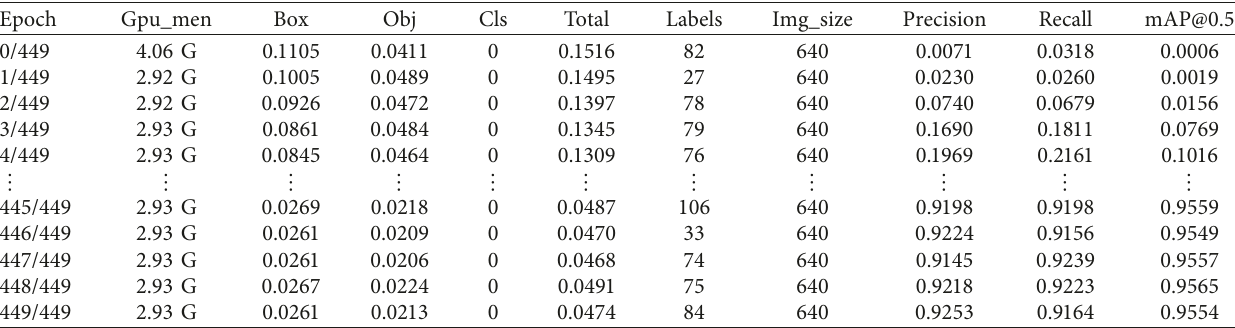
Table 4: YOLO v3 training results.